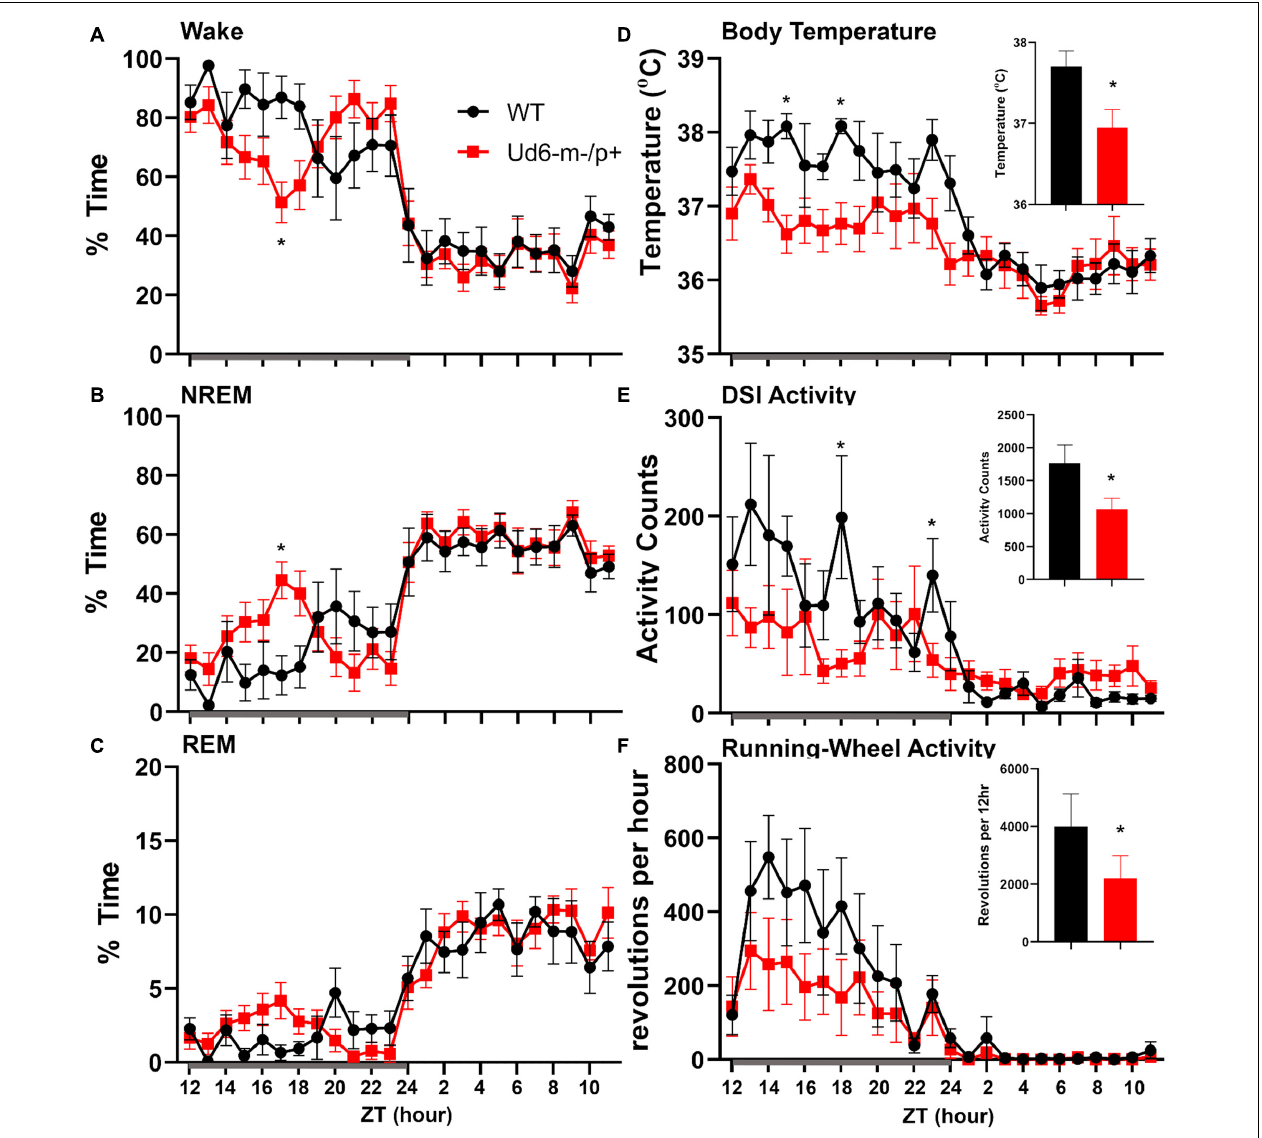
FIGURE 9 | Sleep/wake behavior in LD for mice with access to running wheels. Amounts of wake (A) , NREM sleep (B) , and REM sleep (C) are similar in WT (black) and Ud6-m-/p+ mice (red). During the dark interval, Ud6-m-/p+ mice have lower body temperature (D) , and reduced activity as recorded by DSI telemetry (E) , and running-wheel revolutions (F) . Darkness is indicated by the gray horizontal bar from ZT12-24. Insets summarize the data for the 12-h dark interval for WT (black) and Ud6-m-/p+ (red). Data are plotted as mean ± SEM. Asterisk (*) indicates a significant difference between Ud6-m-/p+ vs. WT mice at the p < 0.05